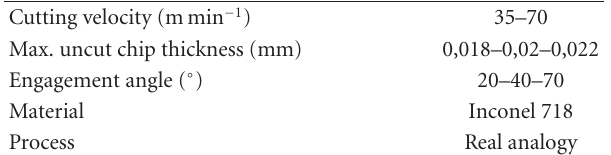
Table 1: Summary of cutting